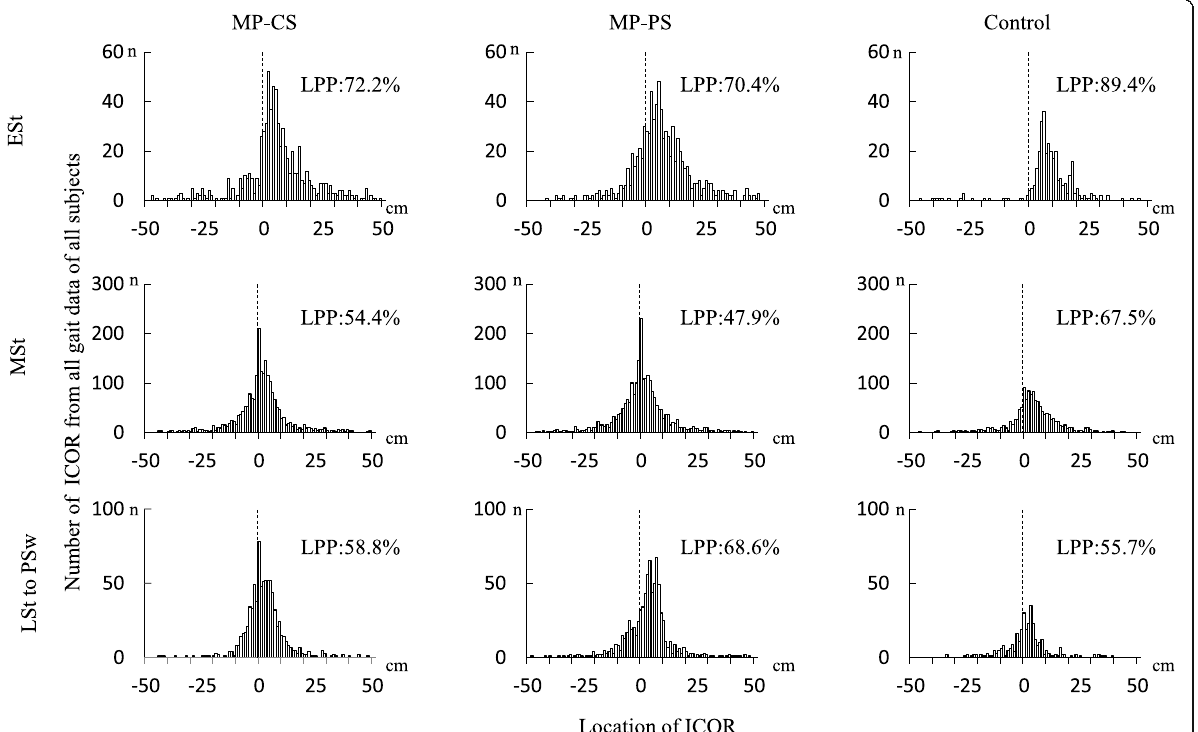
Fig. 4 Distribution of all x-coordinates of the ICOR in each phase of gait. The “ 0 ” on the horizontal axis indicates the center of the tibial plateau. The LPP indicates lateral pivot proportion (%). ICOR, instantaneous center of axial rotation; ESt, early stance; MSt, mid-stance; LSt, late stance; PSw,